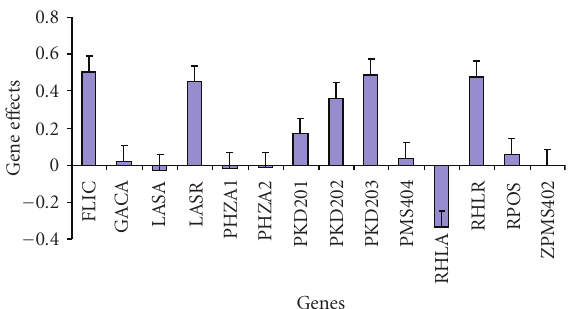
Figure 5: The estimation of gene e ff ects under condition TSBDC + 50 ug/mL FeCl 3